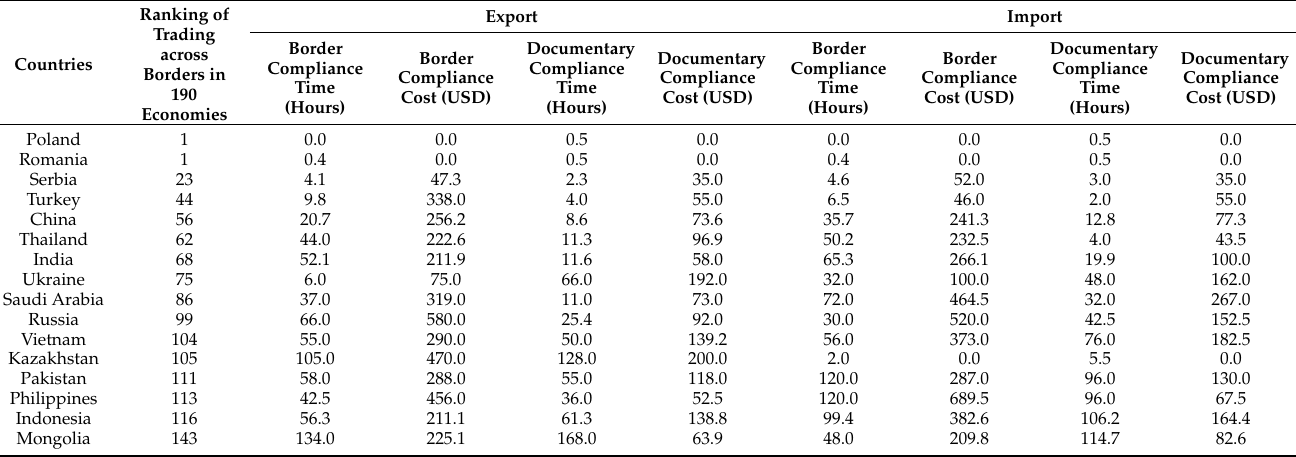
Table 6. The facilitation degree of trading cross borders in main countries along the B&R and China in